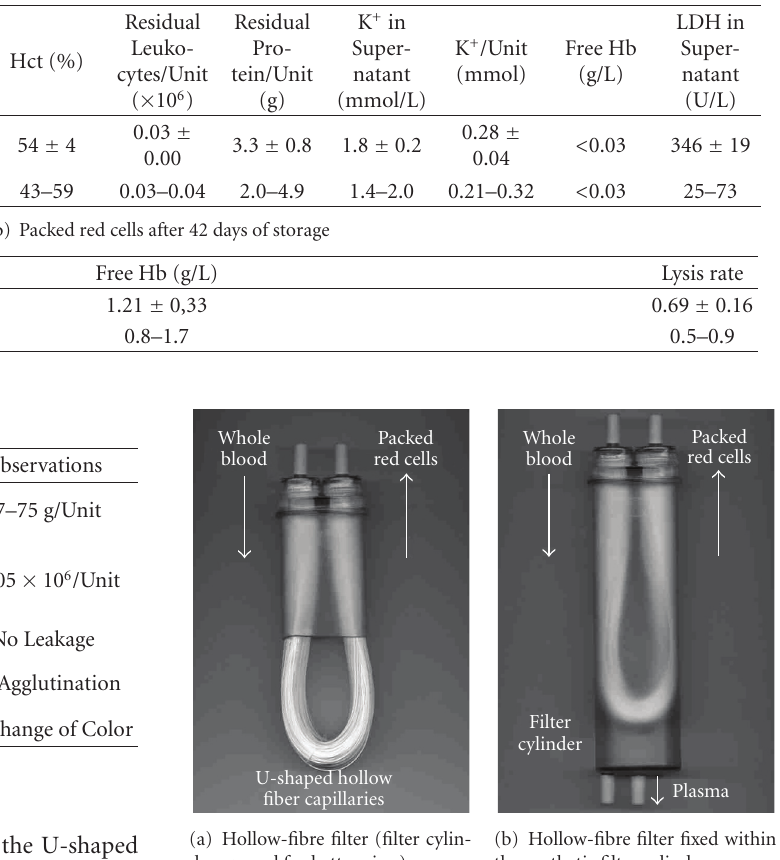
Figure 1: Figures 1(a) and 1(b) show the hollow-fibre filter in more detail. Each hollow-fibre filter is made of 600 capillary membranes, produced from polyethersulfon with a thickness of 100 µ m ± 25 µ